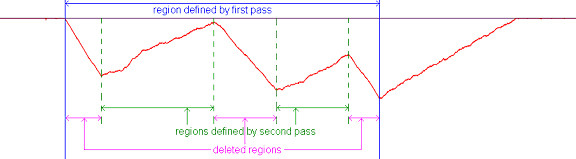
The second iteration detects conserved regions within first iteration regions.